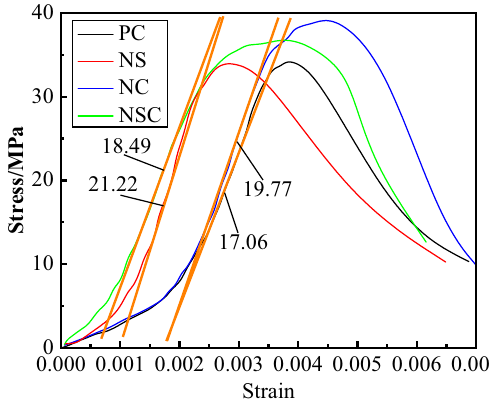
Figure 10. Elastic modulus of concrete.